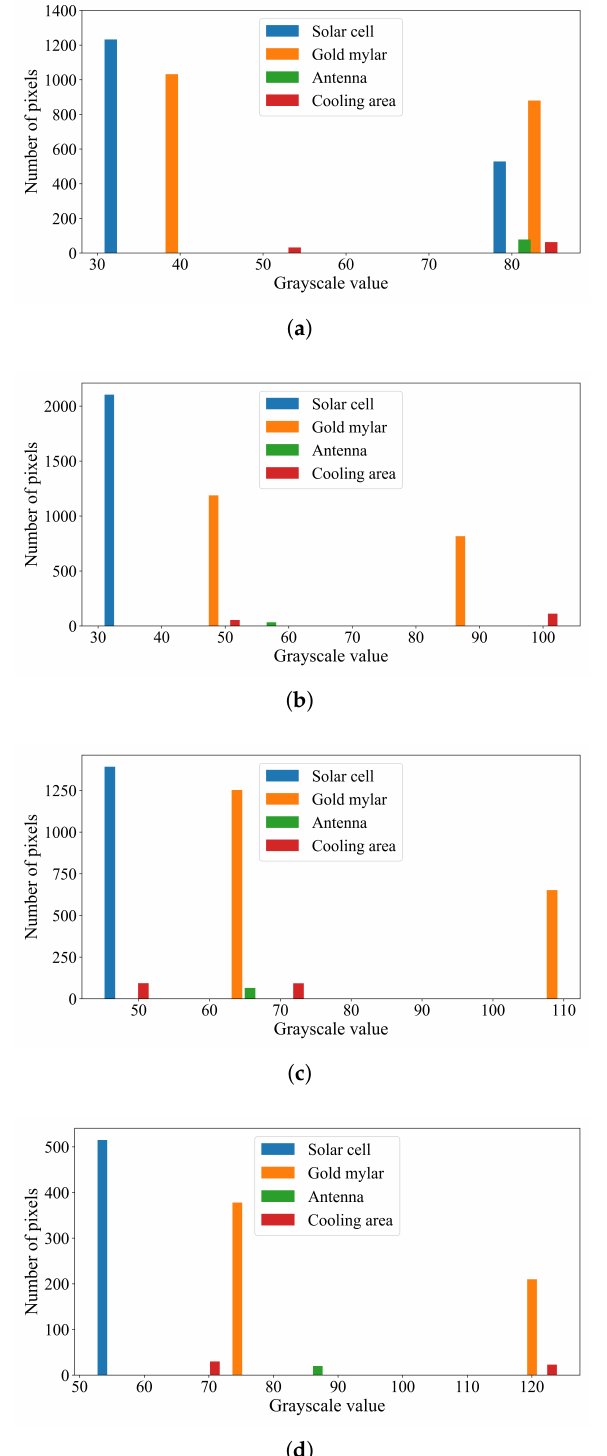
Figure 20. Distributions of grayscale values of different materials in different incidence directions and spatial resolutions: ( a ) high spatial resolution, negative X-axis; ( b ) high spatial resolution, positive Y-axis; ( c ) high spatial resolution, negative Z-axis; ( d ) low spatial resolution, positive